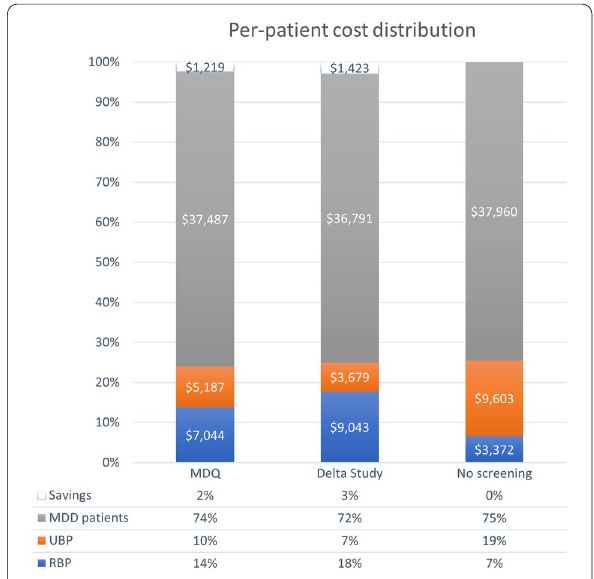
Fig. 3 Cost distributions. Total five‑year distribution of inflation‑adjusted per‑person discounted costs. Grey colour represents costs for correctly diagnosed MDD, orange represents costs for UBP, and blue represents costs for RBP. MDD: Major